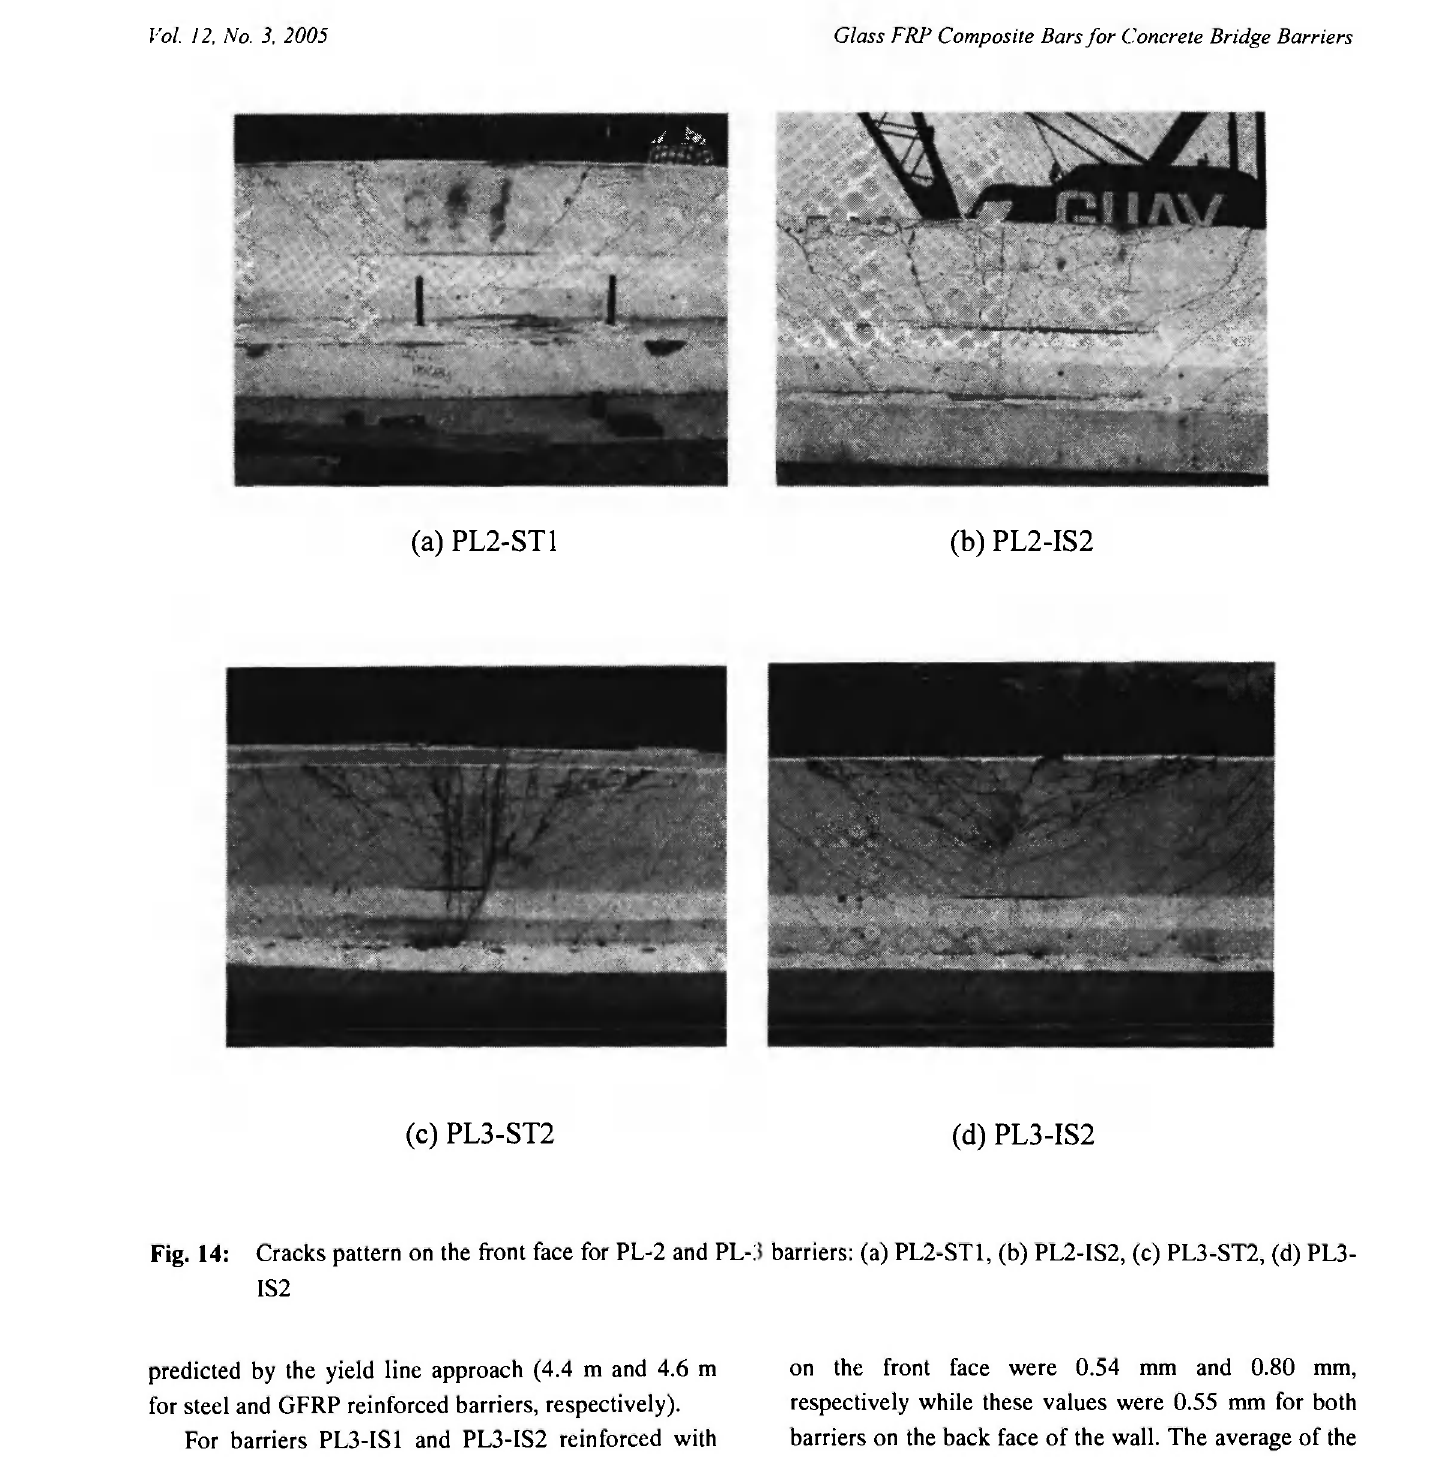
predicted by the yield line approach (4.4 m and 4.6 m for steel and GFRP reinforced barriers, respectively). For barriers PL3-IS1 and PL3-IS2 reinforced with GFRP bars, the density of cracks and the crack widths were very similar to those of their counterparts reinforced with steel. For barriers PL3-ST1 and PL3- ST2, the maximum measured crack widths on the front face were 0.60 mm and 0.56 mm while these values were 0.45 mm and 0.65 mm on the back face of the wall, respectively. On the other hand, for barriers P U-